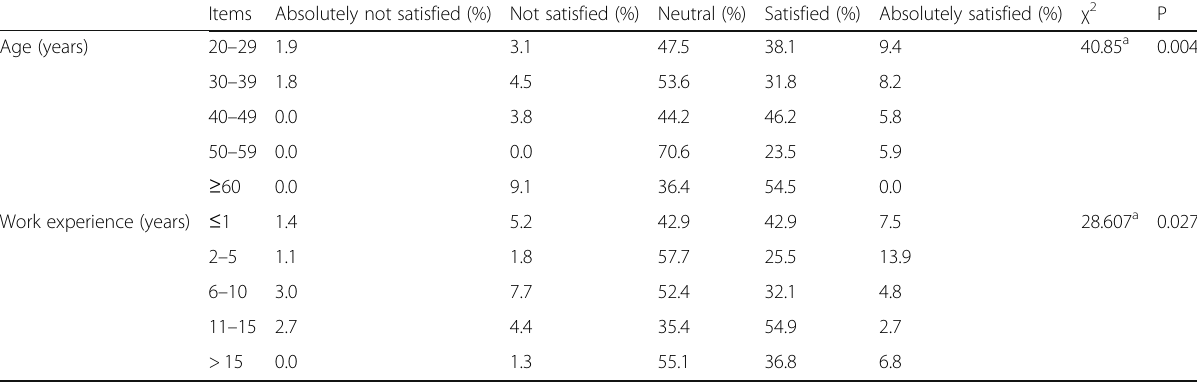
Table 6 Univariate analysis of different population characteristics and satisfaction with TCM for prevention and health